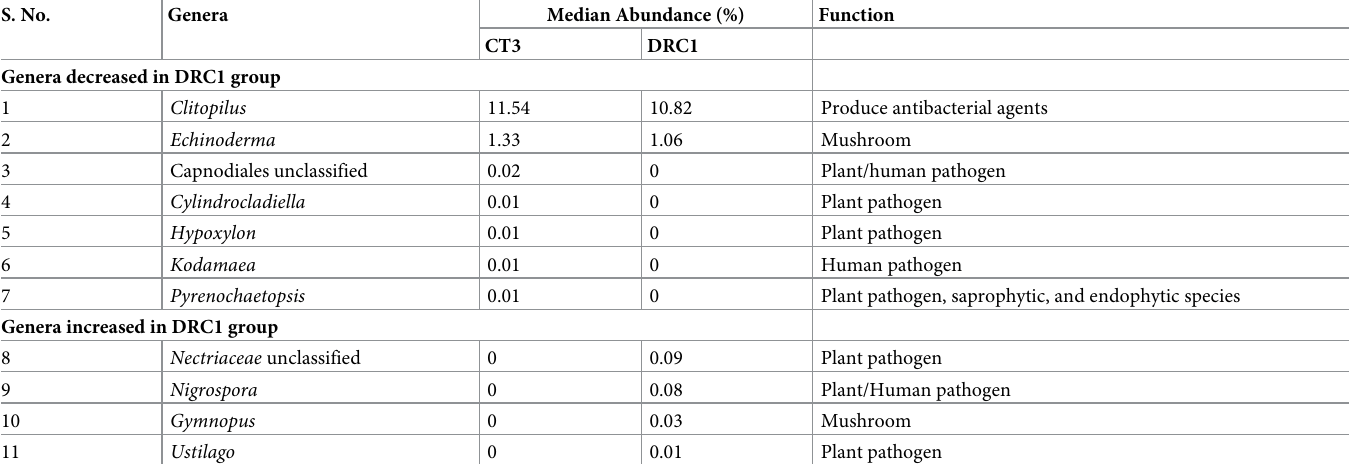
Table 5. Significant differences in the median abundance of discriminatory genera ( > 0.01% in any one of the groups; P-value � 0.05) in gut mycobiomes from con- trol (CT3, n = 6) and diabetic rats showing retinal changes (DRC1, n = 3). S. No.